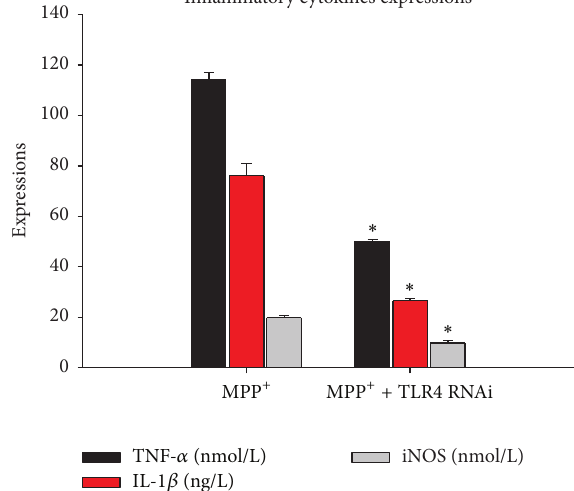
Figure 3: The changes in TNF- 𝛼 , IL-1 𝛽 , and iNOS of the BV- 2 cells exposed to MPP + for 12 h. MPP + was applied to the cells at four concentrations (0.1mM, 0.3 mM, 0.5 mM, and 1mM), and the incubation time was 12 hours. Note that there were significant differences in protein expression between MPP + and control groups. ∗ 𝑃 < 0.05 versus control; ∗∗ 𝑃 < 0.01 versus control.